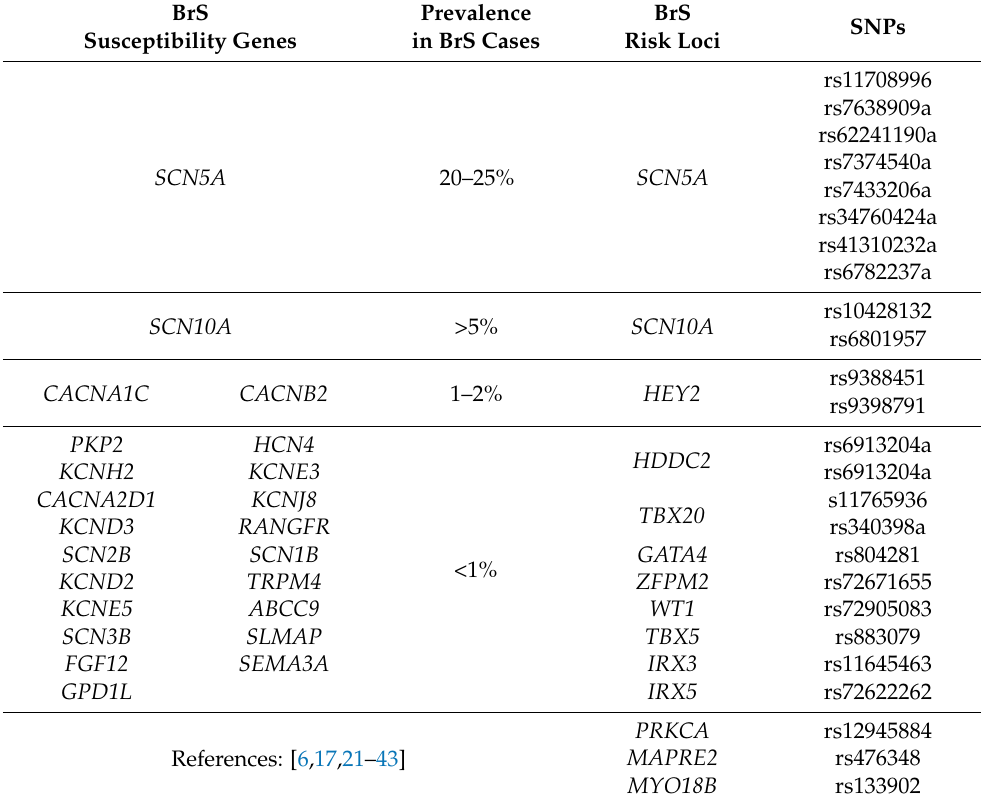
Table 1. Genetics of Brugada syndrome. BrS Susceptibility